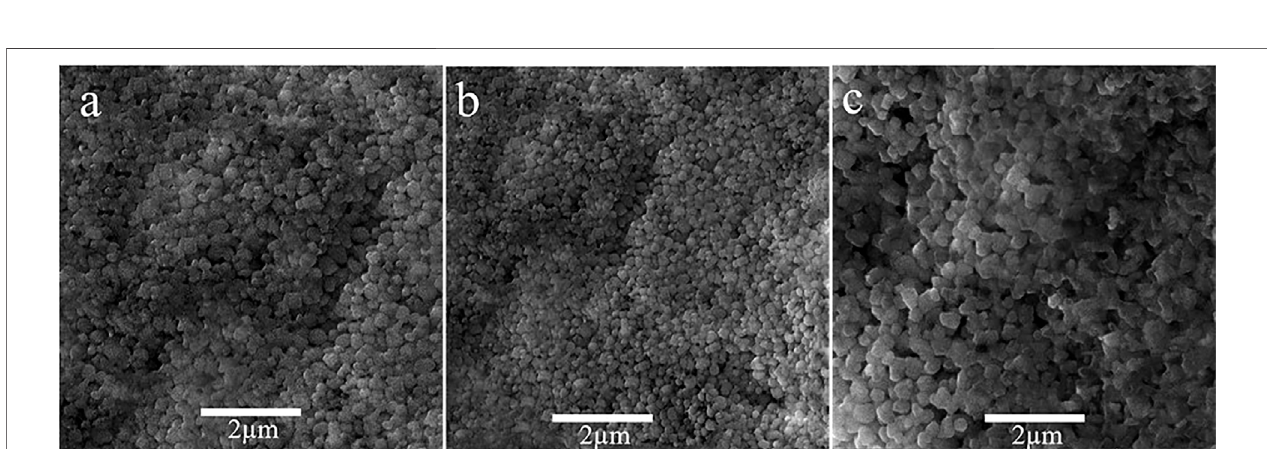
Frontiers in Chemistry |